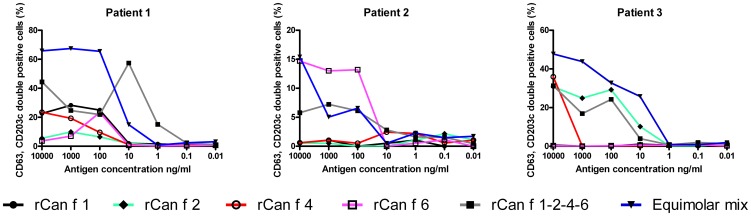
Biologic responses to Can f 1-2-4-6 among dog allergic patients.Allergen-specific basophil degranulation monitored by addition of serial dilutions of rCan f 1 or equimolar amounts of either rCan f 2, rCan f 4, rCan f 6, an equimolar mix or Can f 1-2-4-6 (x-axis) to whole blood from three dog allergic patients. Positivity was defined by analysis of CD63 and CD203c double positive cells (y-axis) using flow cytometry.